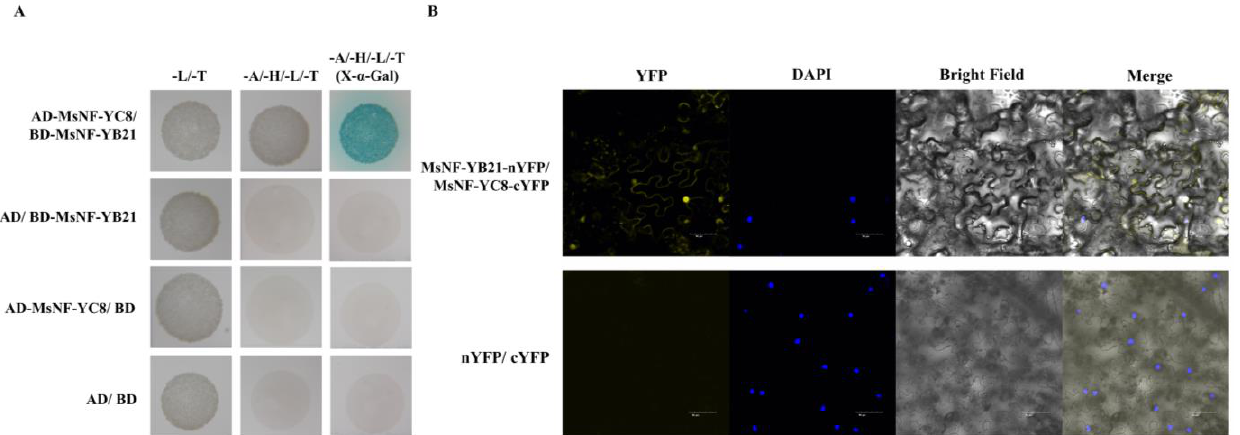
Figure 7. MsNF-YB21 interacts with MsNF-YC8. ( A ) Y2H assays of the interaction between AD-MsNF-YC8 and BD-MsNF- YB21. AD, activation domain. BD, binding domain. ( B ) BiFC assay showing that MsNF-YB21 interacted with MsNF-YC8 in the nucleus and membrane of N. benthamiana epidermal cells. The nuclear dye DAPI (blue) was applied to visualize the nucleus. Scale bars = 50 μm.